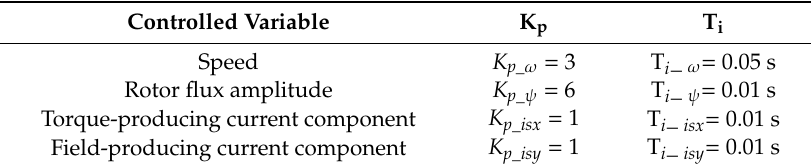
Table A1. Parameters of PI